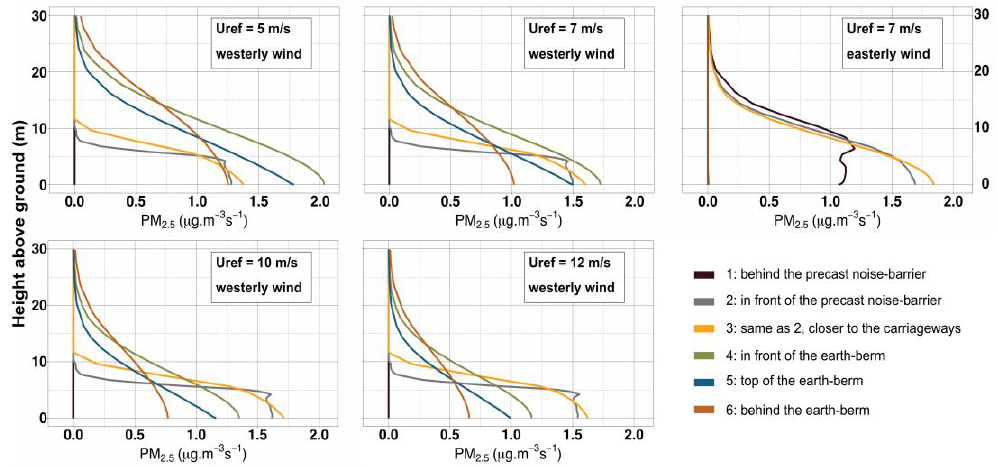
Figure 8. PM 2.5 concentration calculated along six vertical profiles localized on both sides of the berm roofed with a precast noise barrier and the flat-top earth berm (see Figure 2) with reference velocities of 5, 7, 10, and 12 m/s in the prevailing wind direction and 7 m/s in the opposite wind direction.